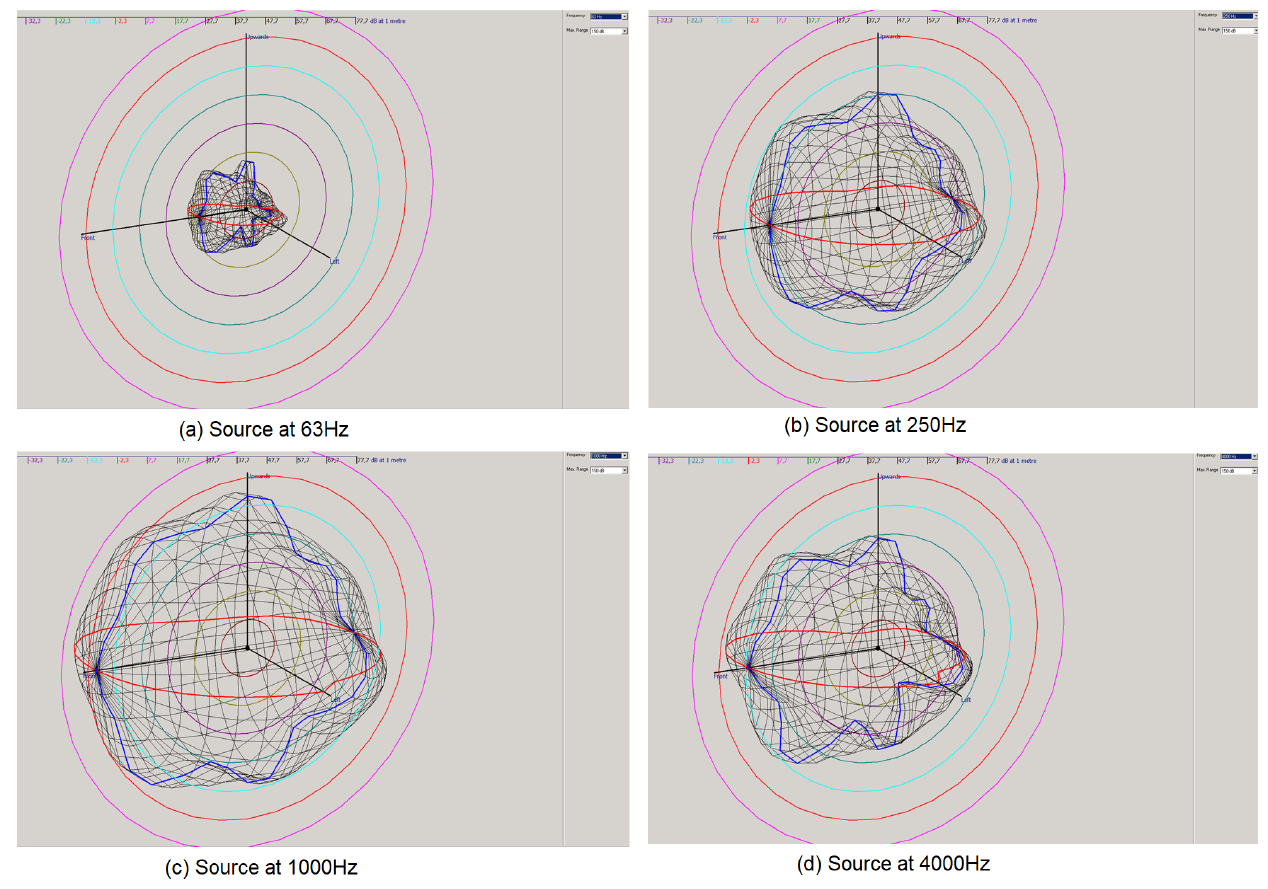
Figure 12. 3D sound source diagrams in ODEON software at different frequencies of the characterized sound source.